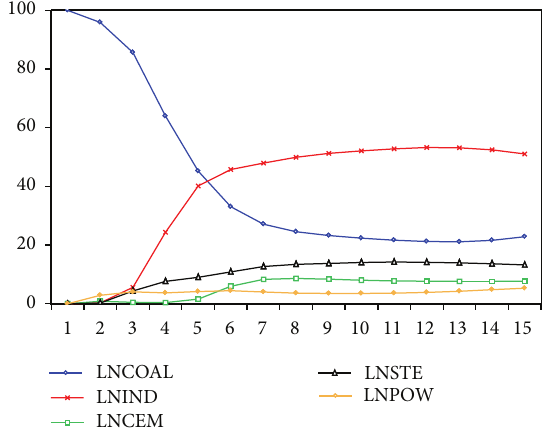
Figure 2: Responses of LNCOAL to LNCOAL, LNIND, LNCEM, LNSTE, and LNPOW.